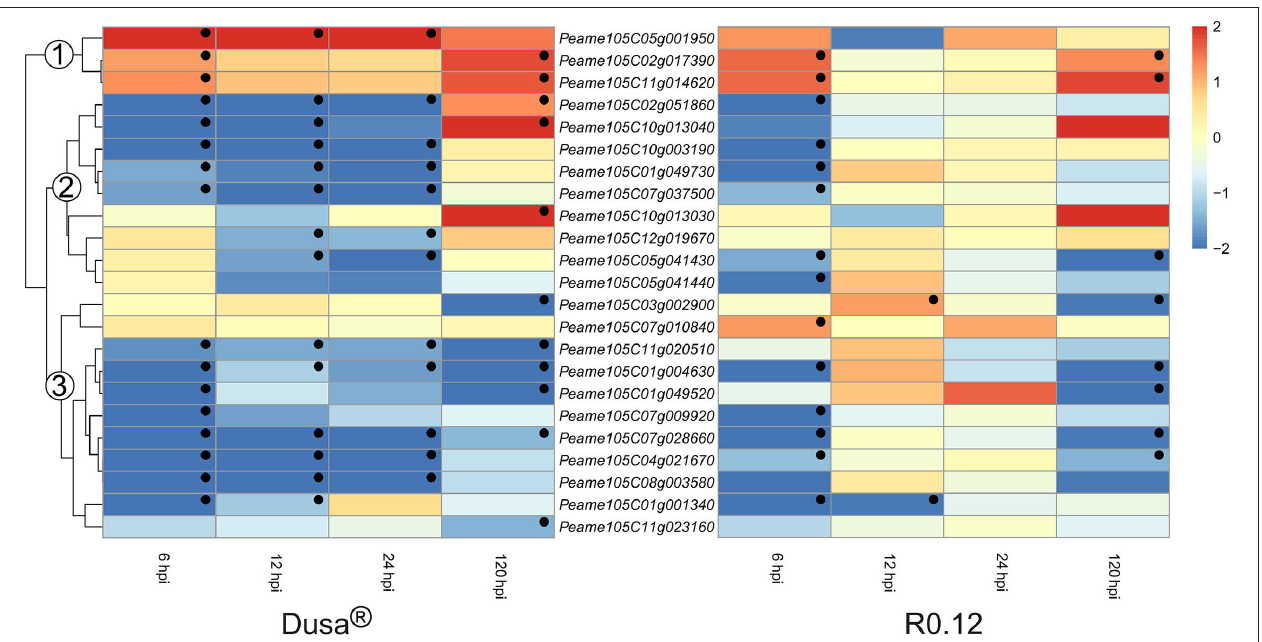
FIGURE 8 | Heatmap and dendrogram illustrating the expression of genes encoding for apoplastic aspartic proteases in Persea americana following inoculation with Phytophthora cinnamomi. Differentially expressed genes (DEGs) encoding for apoplastic aspartic proteases from both partially resistant (Dusa ® ) and susceptible (R0.12) P. americana rootstocks are indicated. Differential expression at 6, 12, 24, and 120h post inoculation (hpi), following inoculation with P. cinnamomi , was calculated using mock-inoculated (dH 2 O) sample libraries as the control. Significantly upregulated [log 2 (fold change) > 1, p = 0.05] genes are indicated by a red color, while significantly downregulated [log 2 (fold change) < − 1, p = 0.05] genes are indicated in blue, the intensity of which represents scale. Significant DEGs are indicated with a black dot. The expression of aspartic protease coding genes was broadly clustered into three groups based on the dendrogram from Dusa ® and were indicated numerically on the dendrogram. Only aspartic proteases that were differentially expressed in one or more samples and were predicted to localize to the cell membrane or extracellular space are